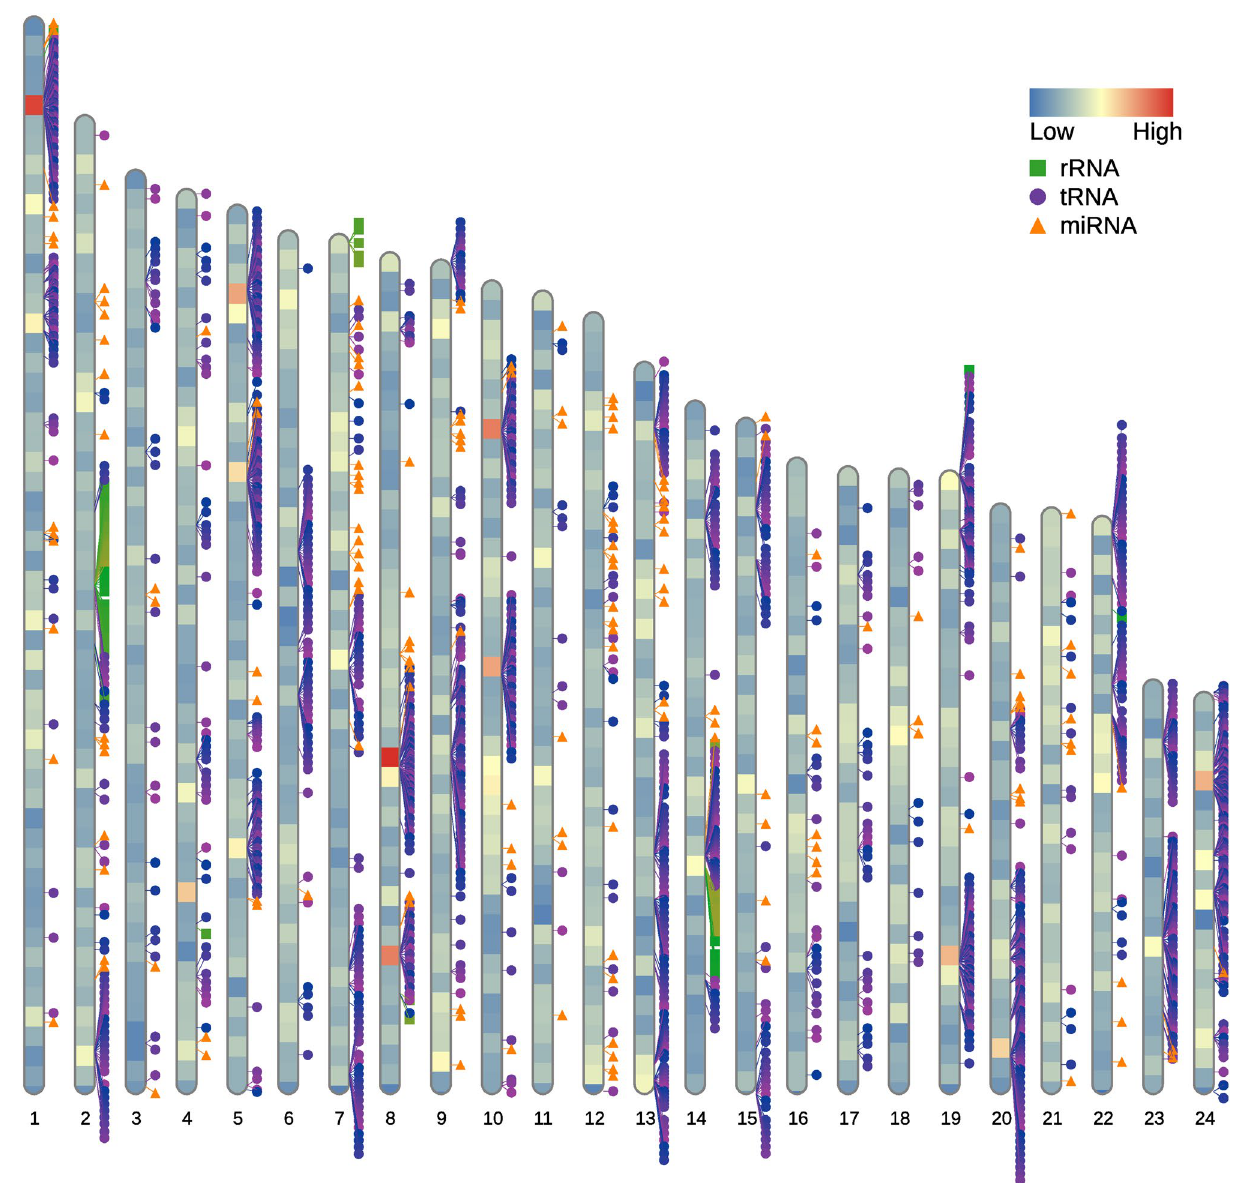
Figure 4. Gene density on each pikeperch chromosome ordered by length and distribution of non-coding RNA loci including miRNA (orange triangle), tRNA (purple circle) and rRNA (green square). The colour code within each chromosome represents the gene density from low (blue) to high (red) in a window of 1